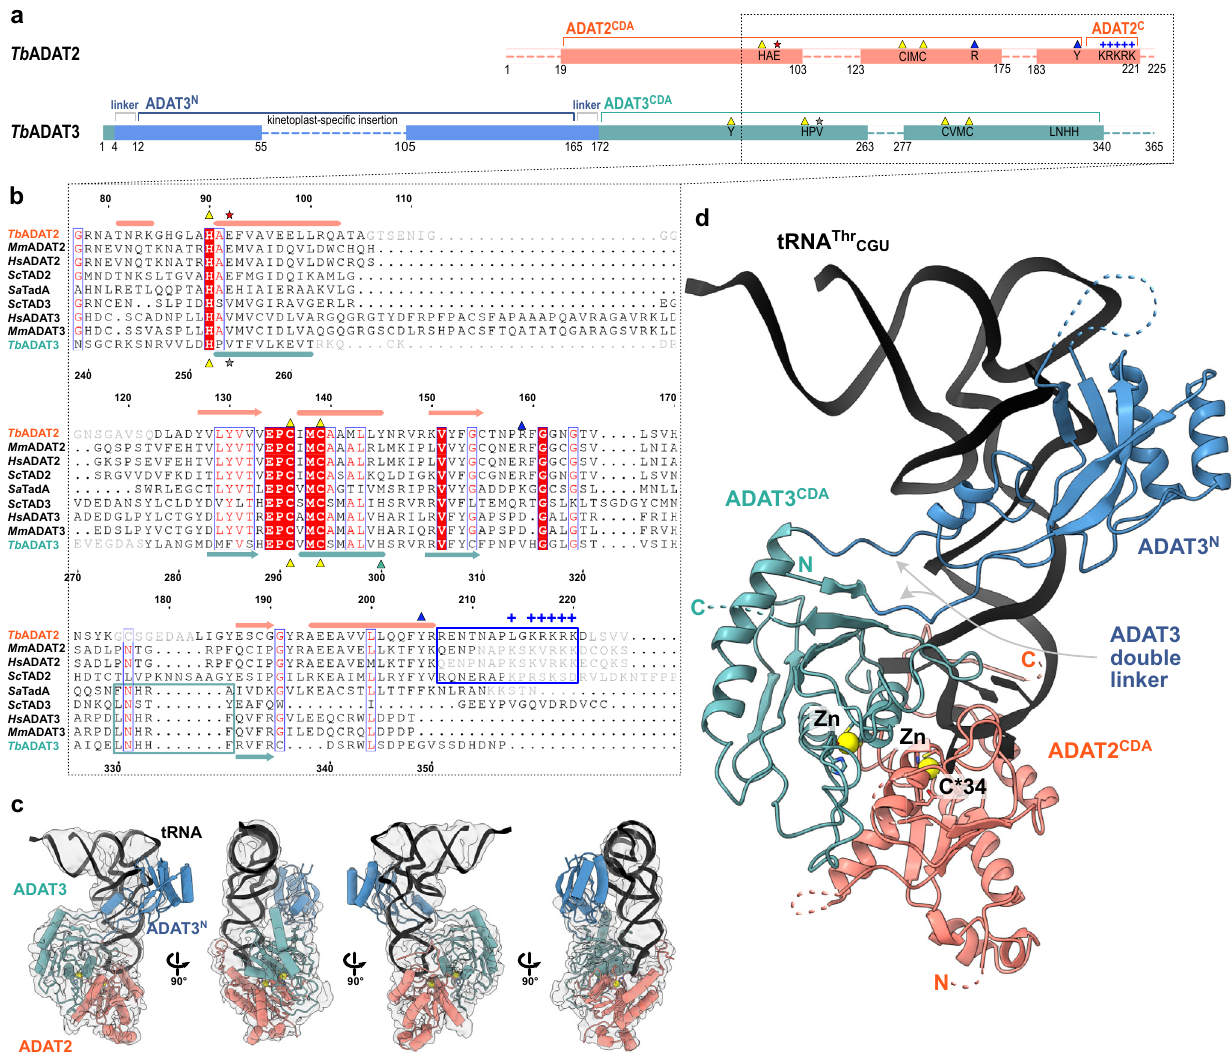
Fig. 1 | The structure of Tb ADAT2/3 heterodimer bound to tRNA Thr CGU . a Schematicrepresentation of the proteinsubunits:ADAT2CDAinsalmon,ADAT3 N-terminal domain in blue, ADAT3 CDA in teal. Portions with traced atomic model as solid colors and non-resolved linkers as dotted lines. Important sequence motifs areannotatedattheirrelativepositions.Zn 2+ coordinatingresiduesareindicatedby yellow triangles, the active-site glutamate / pseudo-active-site valine by a red and gray star, ‘ gate ’ residuesof ADAT2with abluetriangle. Conserved positivecharges oftheKR-motifannotatedasblue “ + “ signs. b Structuralalignmentof Tb ,yeastand mouse ADAT2 and ADAT3 CDA domains and Staphylococcus aureus TadA. The sequences for human ( Hs ) ADAT2/3 included ( Mm ADAT2/3 PDB: 7NZ7, sc TAD2/3 PDB:7BV5, sa TadA PDB: 2B3J). Structural elements of Tb are annotated (ADAT2 above, ADAT3 below) with α -helices as cylinders and β -sheets as arrows. Zn 2+ coordinating residues are indicated by yellow triangles, the active-site glutamate /